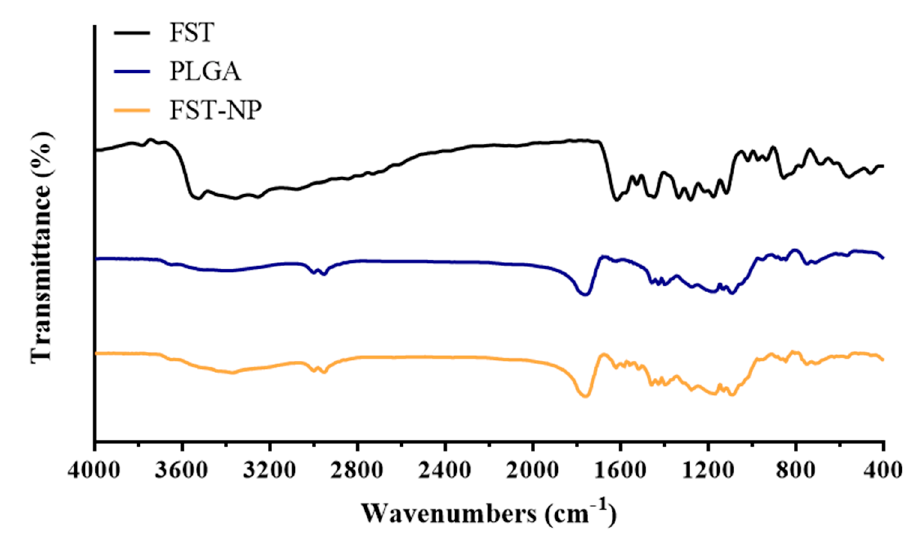
Figure 7. FT–IR spectroscopy of FST, blank PLGA nanoparticles, and FST–NP.